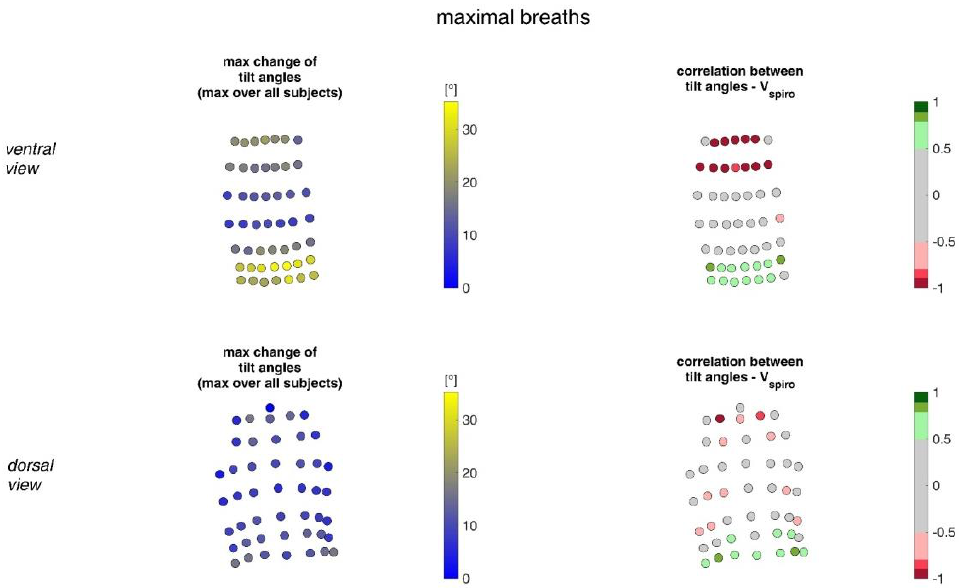
Figure 18. Illustration of the changes of tilt angles at the MoCap marker position at the upper body. The largest tilt angle changes amongst all subjects during maximal breaths (left) and the mean corresponding correlation of maximal tilt angle changes with spirometer volume V spiro of all subjects during maximal breaths are shown (right). (Top - ventral view, bottom - dorsal view).